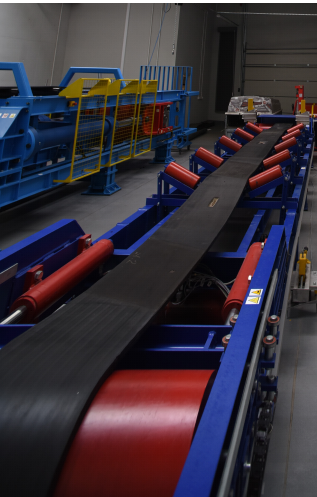
Figure 6. Belt conveyor test rig in GEO3EM Research Center at WUST.